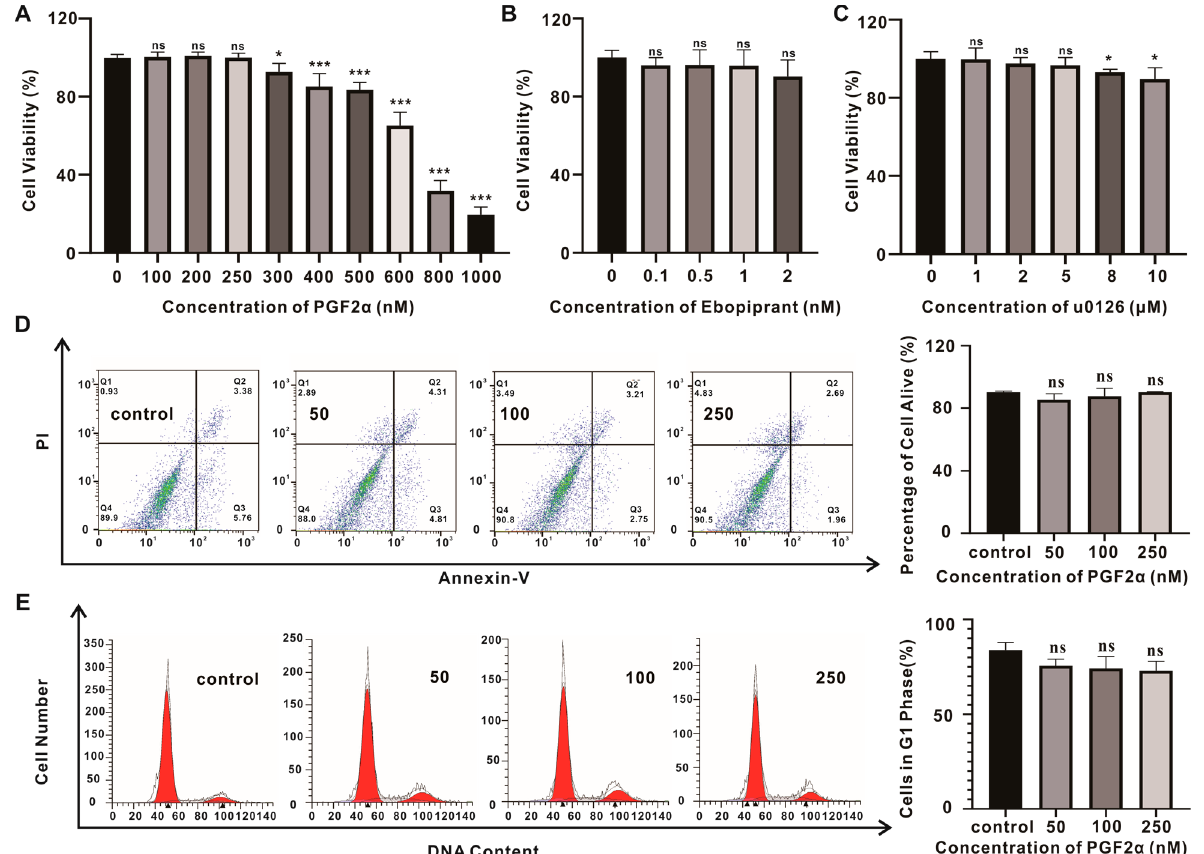
Figure 2. The cytotoxicity study of PGF2 α in GO OFs. ( A – C ) Cell viability measurements using the CCK-8 assay after treatment with PGF2 α , Ebopiprant, or U0126 for 10 d. ( D ) The flow cytometry detection of apoptosis in GO OFs after treatment with PGF2 α ; the alive rate is presented here. ( E ) The representative flow cytometric histograms show the cell cycle distribution after treatment with PGF2 α ; the cells in the G1 phase rate are presented here. Data are presented as the means ± SEMs ( n = 3) (*, p -value < 0.05; ***, p -value < 0.001), ns = not significant.